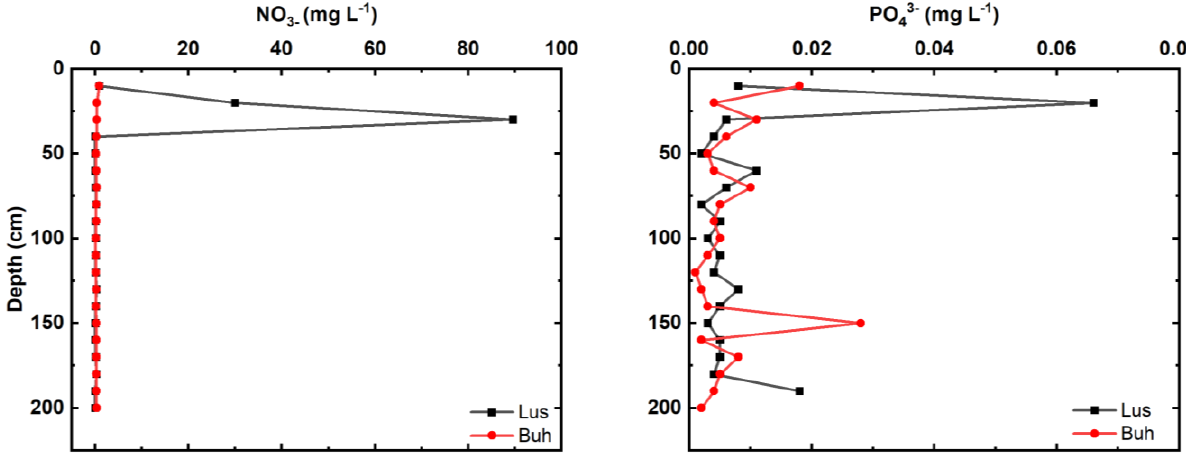
Figure 7. Profiles of nitrate (NO 3- ) and phosphate (PO 43- ) for peat cores from the second (2018) campaign at Buhandanda (Buh) and Lushala (Lus). Table 1. Carbon stock data for the Buhandanda and Lushala peatlands. A V = peat volume, BD = bulk density, C p